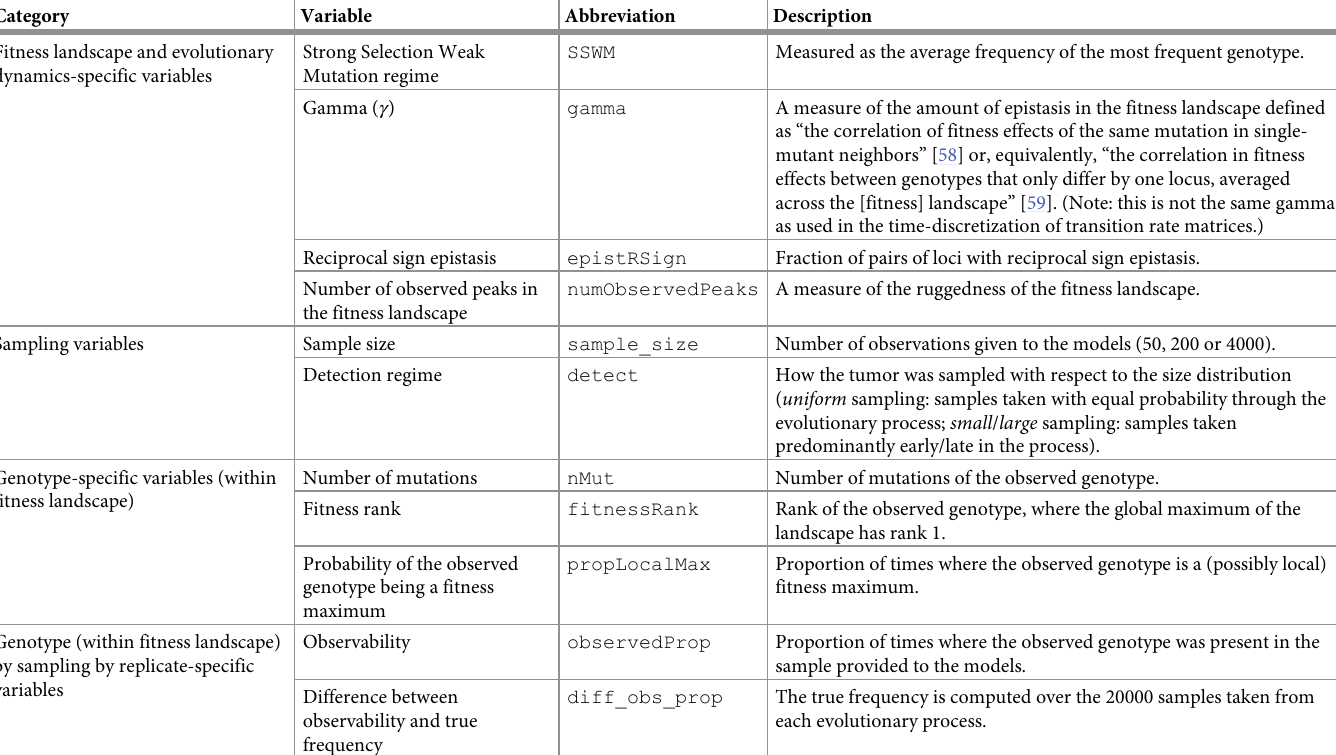
Table 1. Variables potentially affecting predictive performance. Classification and description of the partitioning or predictor variables used in the linear mixed-effects model trees; these are the variables considered as possible sources of variation in the performance of CPMs. The abbreviations correspond to the variable names shown in Fig 2.